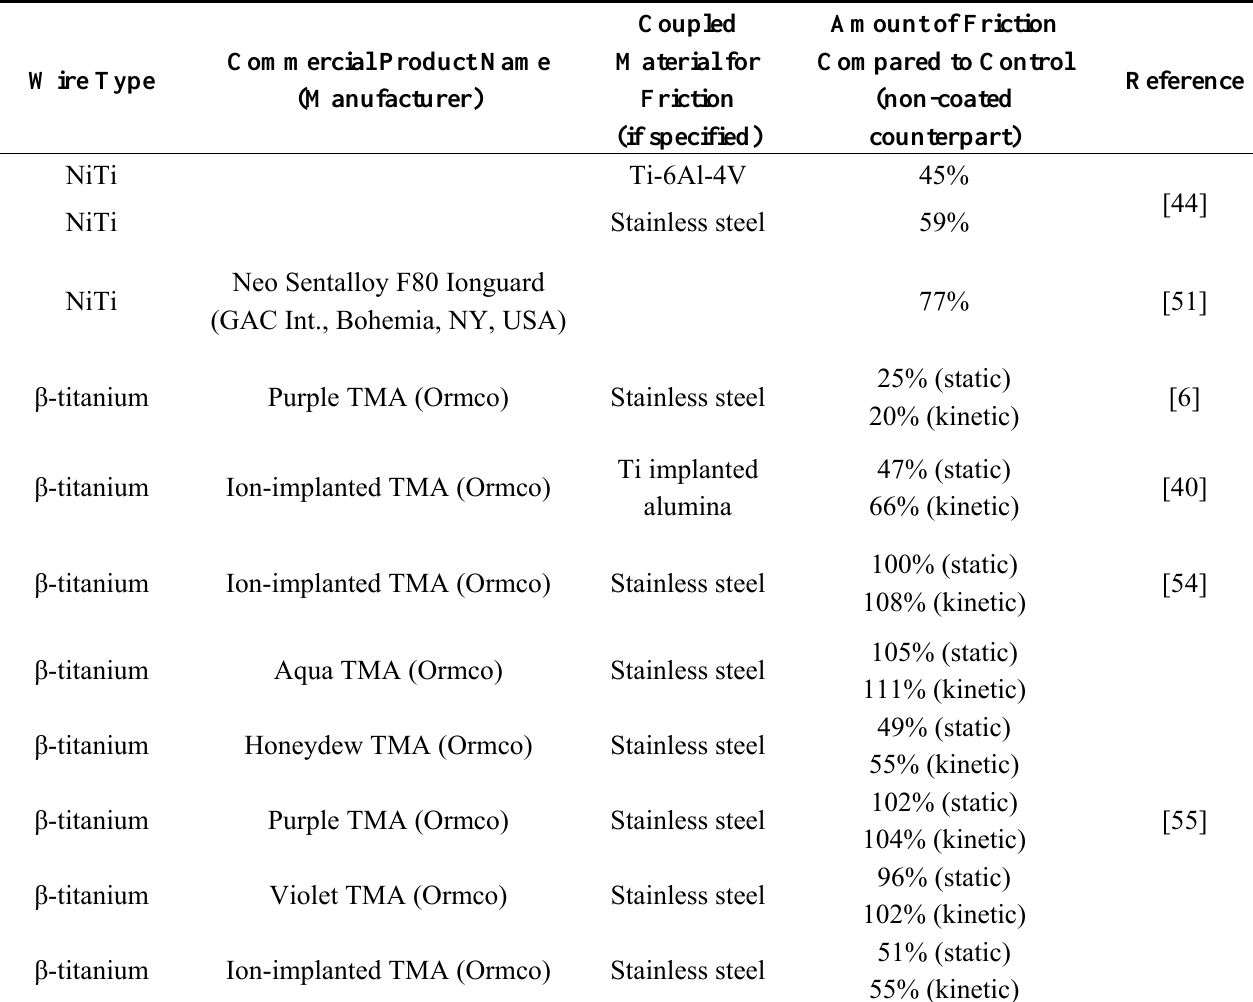
Table 3. Effect of nitrogen implantation on friction observed in several in vitro orthodontic